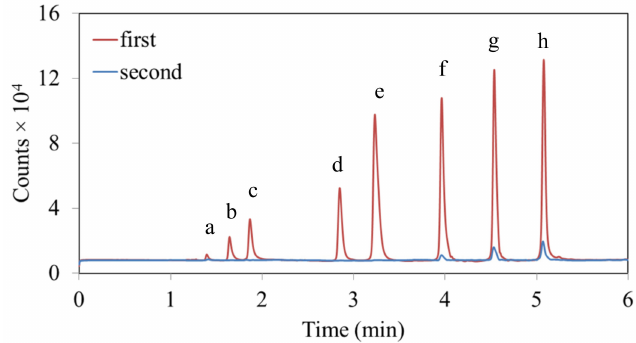
Figure 5. CMSM µ -preconcentrator desorption residual test for a mixture of various compounds. Tested compounds: ( a ) methanol, ( b ) ethanol, ( c ) acetone, ( d ) ethyl acetate, ( e ) benzene, ( f ) toluene, ( g ) m-xylene, and ( h ) mesitylene. All compounds were prepared as a mixture in a Tedlar bag at 100 ppb each. The sample volume for the first GC-FID run was 1.0 L. The sampling flow rate was